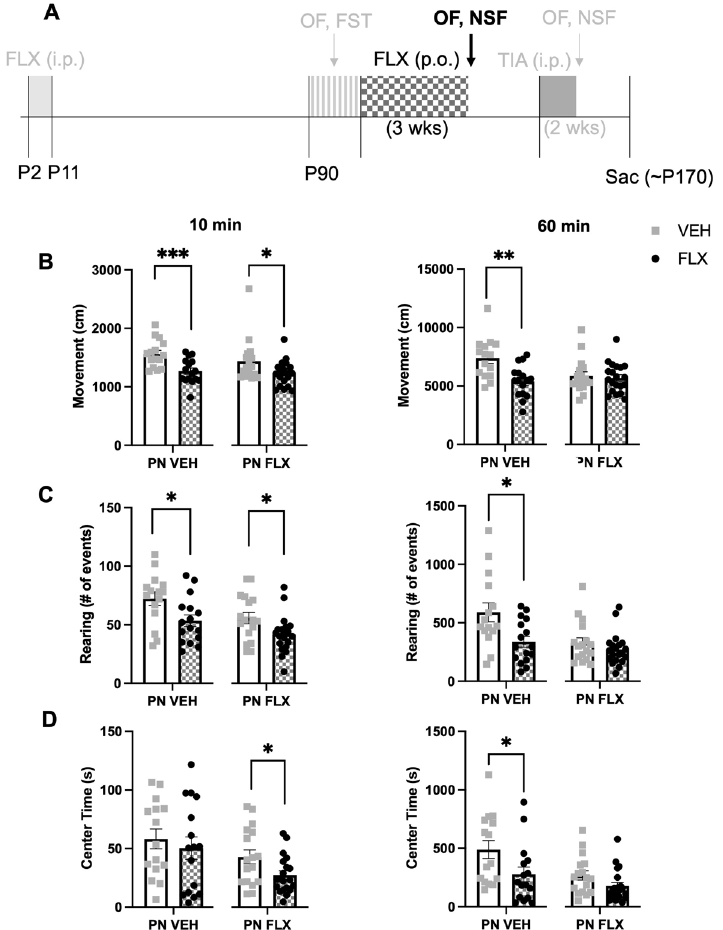
Figure 2. Decreased movement following chronic adult fluoxetine treatment in C57 PNVEH mice and increased avoidant behavior in the first 10 and full 60 min of open field following chronic adult fluoxetine treatment. ( A ) Timeline of experiment: The window for developmental administration of fluoxetine as well as prior phenotyping and future experiments are in faded light grey; Black and checkered grey indicate chronic fluoxetine administration in adulthood and follow up NSF and OF tests. ( B ) Ambulatory movements in the first 10 min of open field (left panel; PNVEH: unpaired t-test, *** p = 0.001; PNFLX: unpaired t-test, * p = 0.044). Same for total 60 min (right panel; PNVEH: unpaired t-test, ** p = 0.0014; PNFLX: unpaired t-test, p = 0.7012) ( C ) Rearing movements in the first 10 min (left panel; PNVEH: unpaired t-test, * p = 0.0188; PNFLX: unpaired t-test, * p = 0.0224). For total 60 min (right panel; PNVEH: unpaired t-test, * p = 0.0103; PNFLX: unpaired t-test, p = 0.2847) ( D ) Time spent in center in the first 10 min (left panel; PNVEH: unpaired t-test, p = 0.5455; PNFLX: unpaired t-test, * p = 0.0268). For total 60 min (right panel; PNVEH: unpaired t-test, * p = 0.0418; PNFLX: unpaired t-test, p = 0.0745). Light gray squares represent adult vehicle-treated animals. Black circles and checkered bars represent adult fluoxetine-treated animals. N = 15 PNVEH-VEH, 16 PNVEH-FLX, 17 PNFLX-VEH, 20 PNFLX-FLX Bars represent mean. Error bars represent standard error. * p < 0.05, ** p < 0.01, *** p < 0.001, **** p <